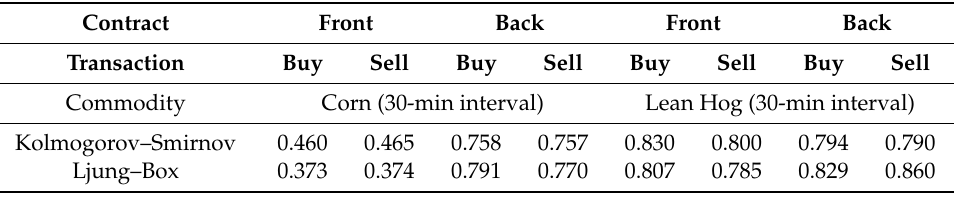
Table A2. Residual analyses (corn, lean hog) for a 30-min interval.